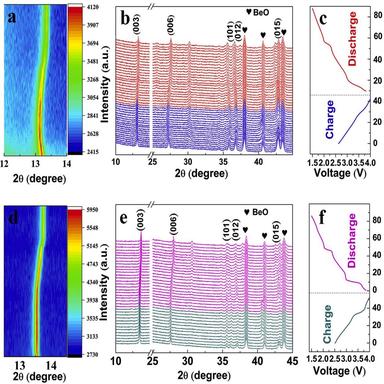
In situ XRD patterns collected at initial cycling. The image plots of the in situ XRD peaks for the peak of (003), in situ XRD patterns collected during the first charge and discharge processes at 10�–45� and the first cycle charge/discharge profiles under a current density of 10 mA g 1 within the voltage range of 1.5–4.0 V for Al-doped (a b c) and pristine (d e f), respectively.